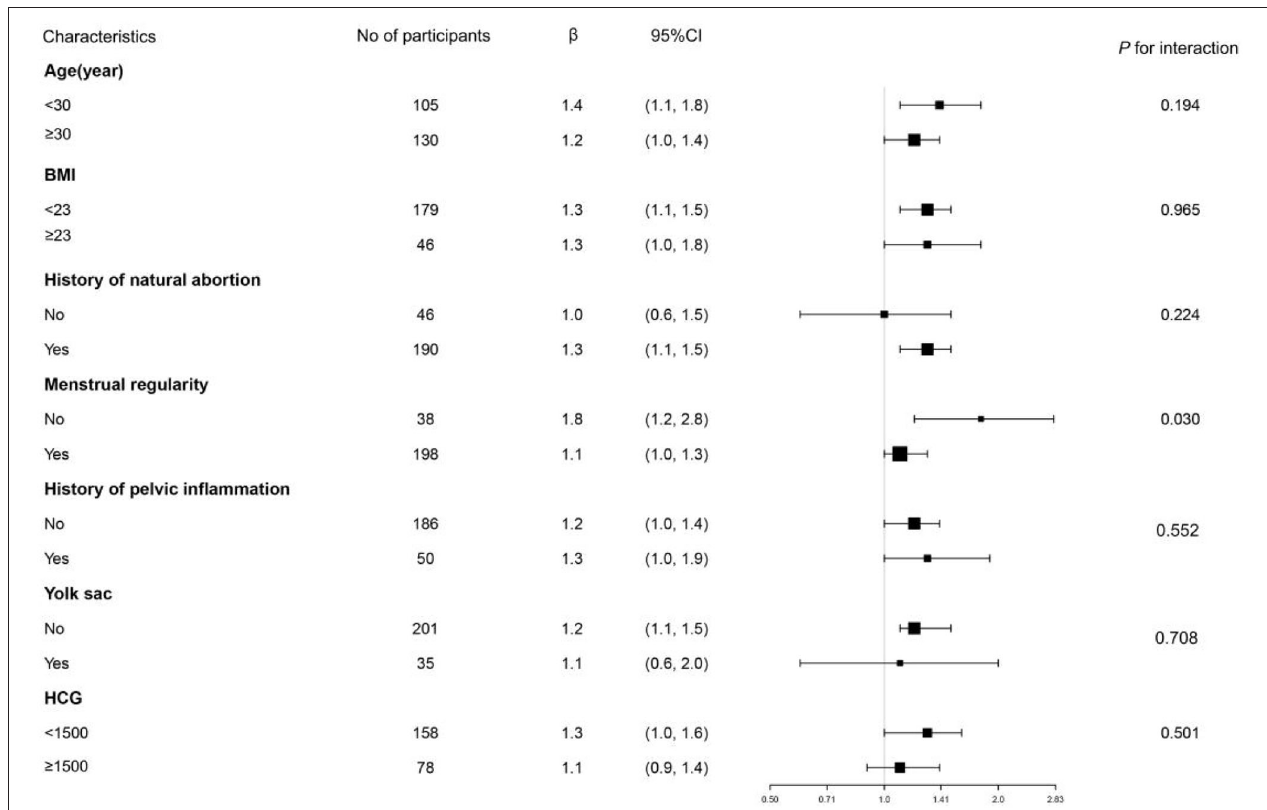
FIGURE 2 | Tree View of subgroup analysis of WBC count and MTX treatment failure the tree diagram displays the results of subgroup analysis. It indicates that the test for interaction was significant for menstrual regularity ( p for interaction = 0.031). In EP patients with regular menstruation, OR was 1.1 (1.0–1.3). In patients with irregular menstruation, OR was 1.8 (1.2–2.8). p for interaction was not significant in age, BMI, history of natural abortion, history of pelvic inflammation, yolk sac, and baseline